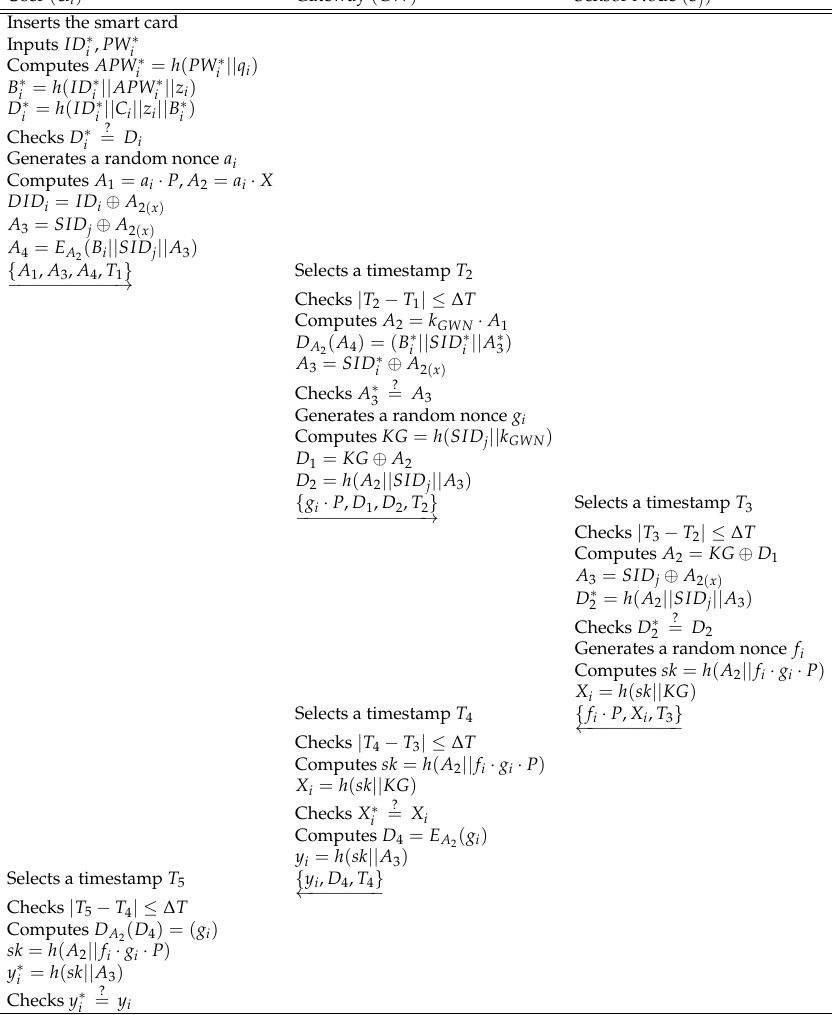
Figure 4. Login and authentication phase of Moghadam et al.’s